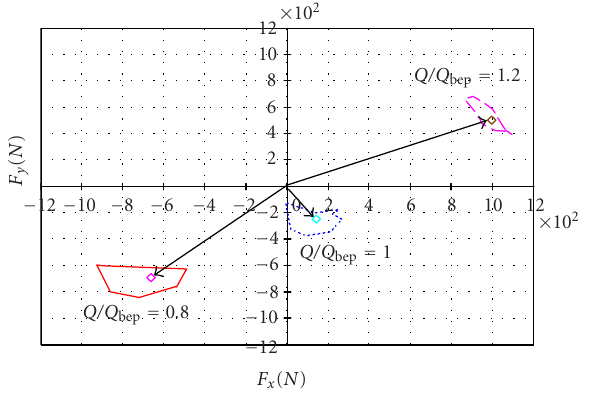
Figure 23: Module and direction of radial force at di ff erent pump capacities (0 . 8 Q bep , 1 . 0 Q bep , and 1 . 2 Q bep ).